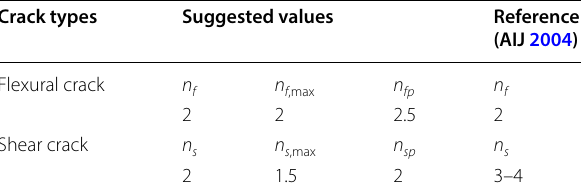
Table 7 Suggested values of n